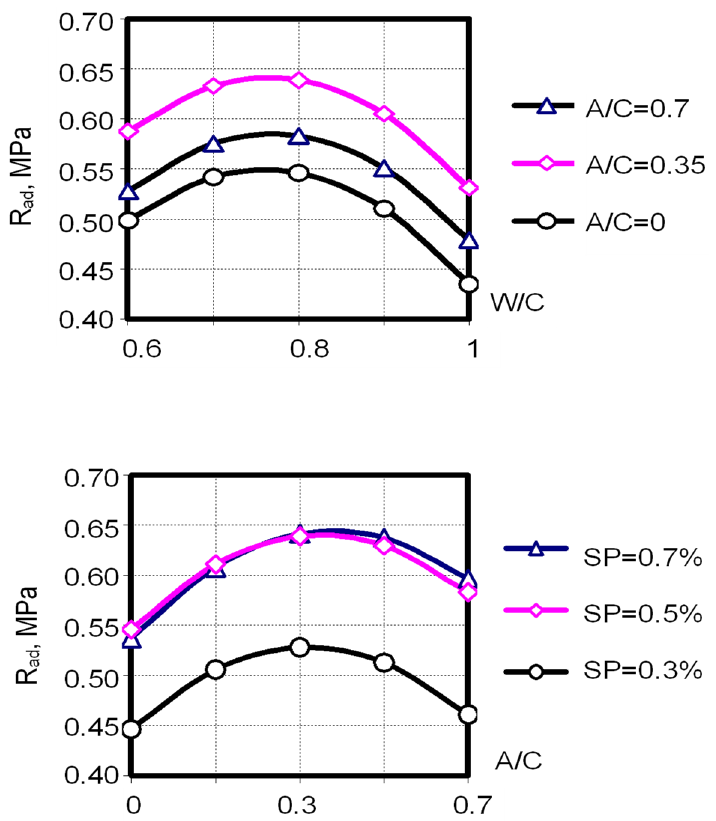
Figure 1. Dependence of the adhesive strength (MPa) of PFM 1 -modified cement–ash mortars on water–cement and ash–cement ratios at 7 days.